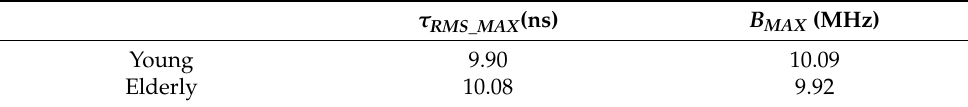
Table 3. Maximum delay spread τ RMS_MAX and maximum data